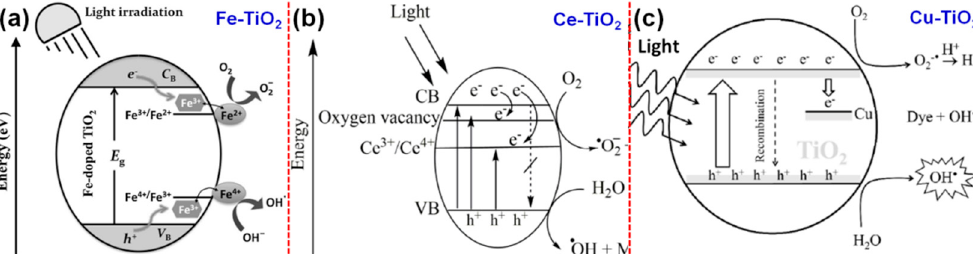
Figure 4. Band gap engineering in TiO 2 via ( a ) Fe, ( b ) Ce, ( c ) Cu doping, showing the formation of dopant energy states underneath the conduction band of TiO 2 and associated carrier dynamics (reproduced with permission from refs. [70–72], respectively).